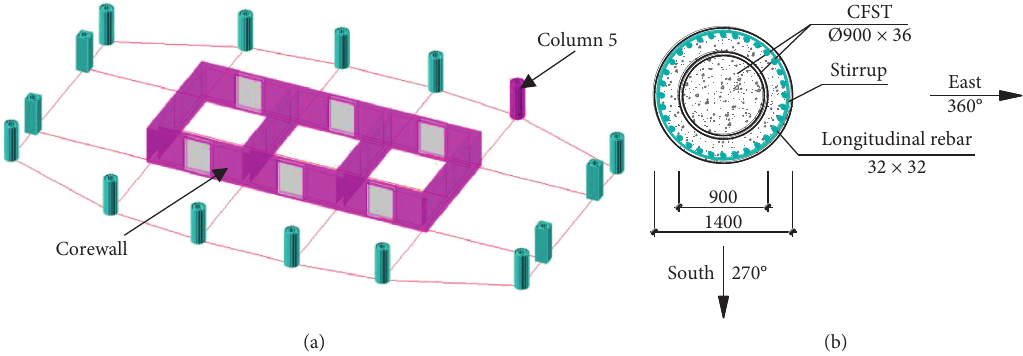
Figure 1: (a) Standard floor plan and (b) column 5 section on the 15 th floor (unit: mm).